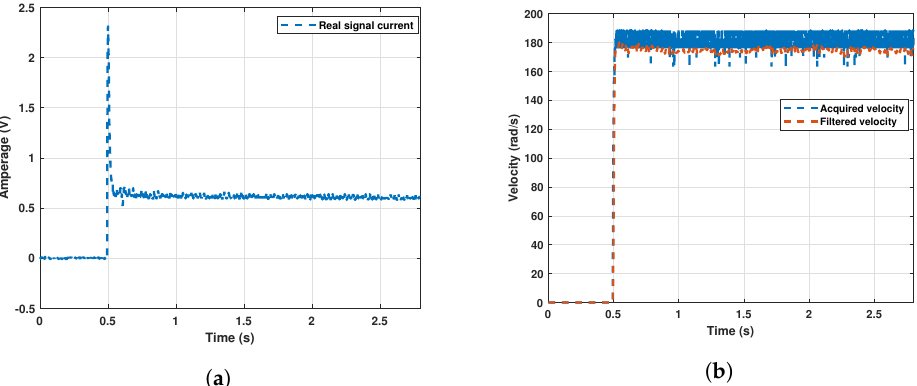
Figure 15. Sensed velocity and current signals for Motor 1. ( a ) Current signal of Motor 1; ( b ) Velocity signal of Motor 1.